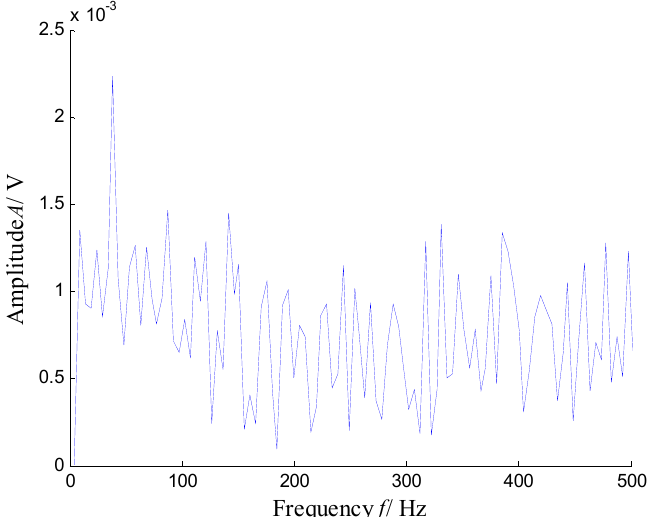
Figure 10. Filtered signal.